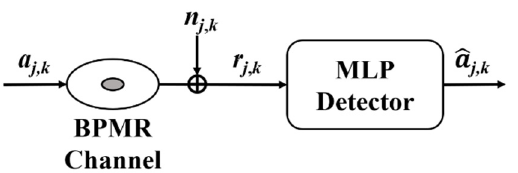
Figure 1. Block diagram of BPMR system with the soft output MLP detector.